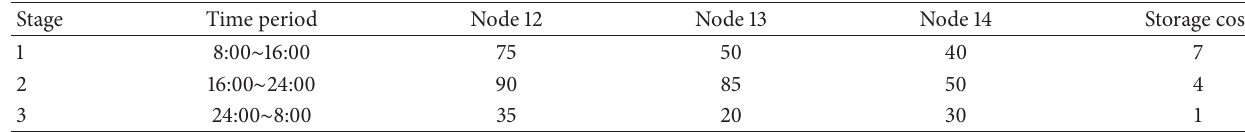
Table 8: The demand and unit storage cost in different stages.